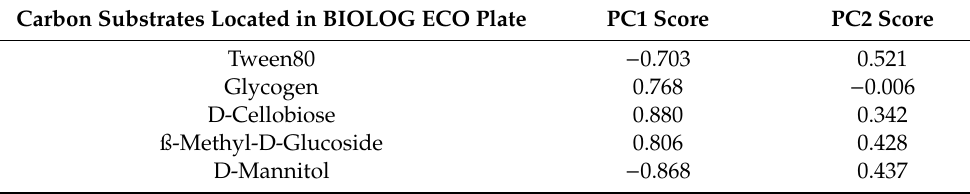
Figure 4. Principal components analysisof thirty one different sole carbon substrate metabolic profiles of the associated bacteria during degradation of phytoplankton. PC1 explained 46.76% of the total variance and PC2 explained 21.49%, respectively. Table 6. Higher discrimination of carbon substrates in the principle component analysis of the data of carbon sources utilization by the associated bacterial community.